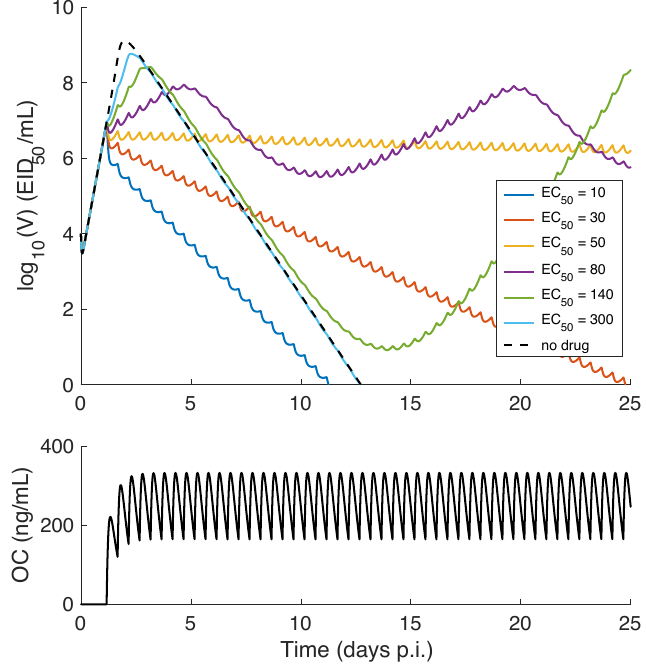
Figure 4. Dependence of viral load profile on drug efficacy for the TIV model. The time course of plasma oseltamivir carboxylate (OC) concentration is shown in ( B ). For EC 50 (half maximal effective concentration) varying from 10 ng/mL to 300 ng/mL, corresponding viral load solutions are shown in ( A ) with different colours. The solution with no drug applied is shown by the dashed black curve. EID 50 /mL : 50% egg infective